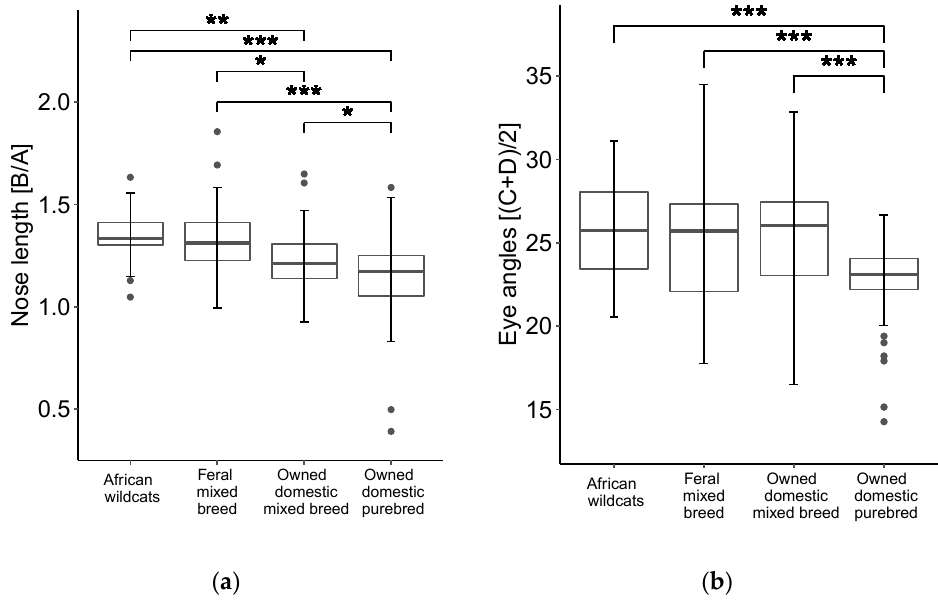
Figure 4. ( a ) Nose length [B/A]; ( b ) eye angles [(C + D)/2]; the bold lines represent the medians. * p < 0.05, ** p < 0.01, *** p < 0.001.